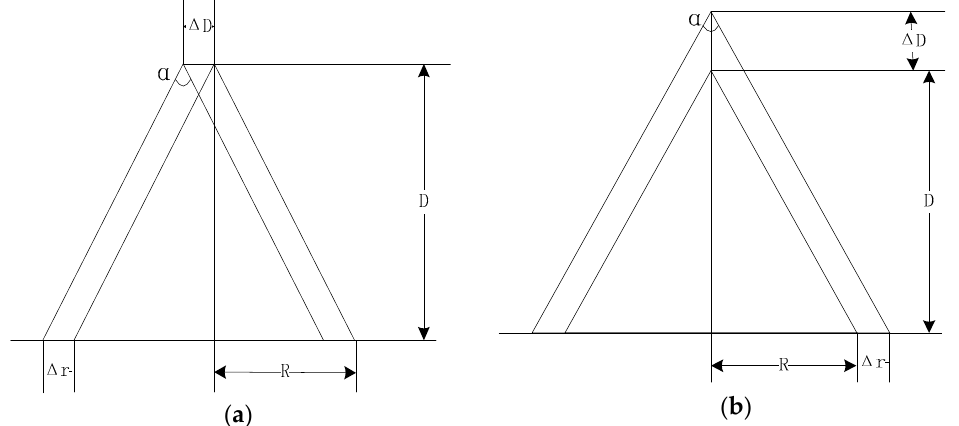
Figure 6. Two differences between image skyline and ground truth skyline: ( a ) The offset direction is orthogonal to the image viewing direction. ( b ) The offset direction is parallel to the image viewing direction. The distance between the image taken point and the skyline is denoted as D. The field of view (FoV) of the camera is α . The error between skylines is Δ D. The length of the skyline is 2R.